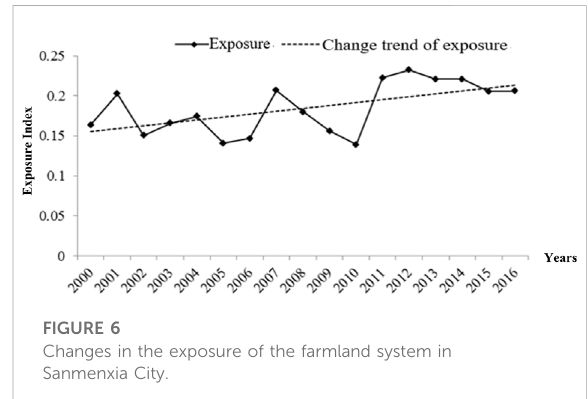
FIGURE 6 Changes in the exposure of the farmland system in Sanmenxia